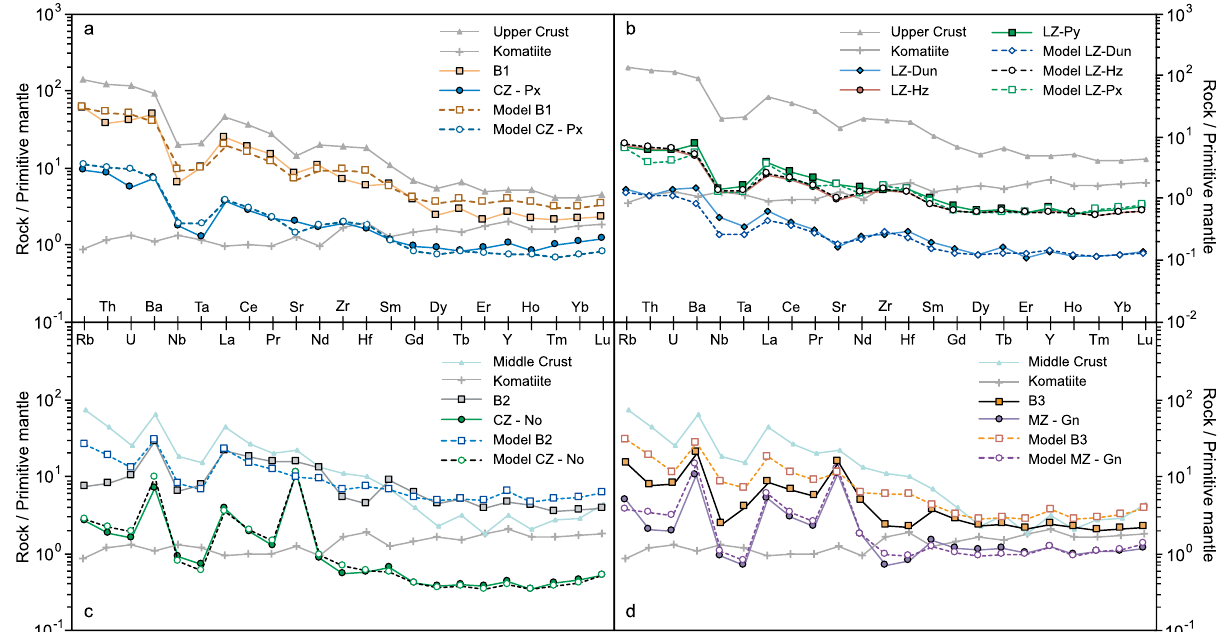
Fig. 4 Primitive mantle-normalized trace-element concentrations for natural and model rocks from the RLS. Solid symbols joined by solid lines represent average compositions of rocks from the RLS, while open symbols joined by dashed lines represent alphaMELTS models. The ABC model accounts for the trace-element patterns of a B1-Px (Critical Zone) lineage and b other Lower Zone and Critical Zone ultrama fi c macrolayers. Additionally, the trace-element compositions of the c B2-No (Critical Zone) lineage and d B3-Gn (Main Zone) lineage coincide with the modeling results of two-stage ABC processes. Compositions of upper crust, middle crust, and komatiite are shown in Supplementary Table 3. Source data are provided as a Source Data fi